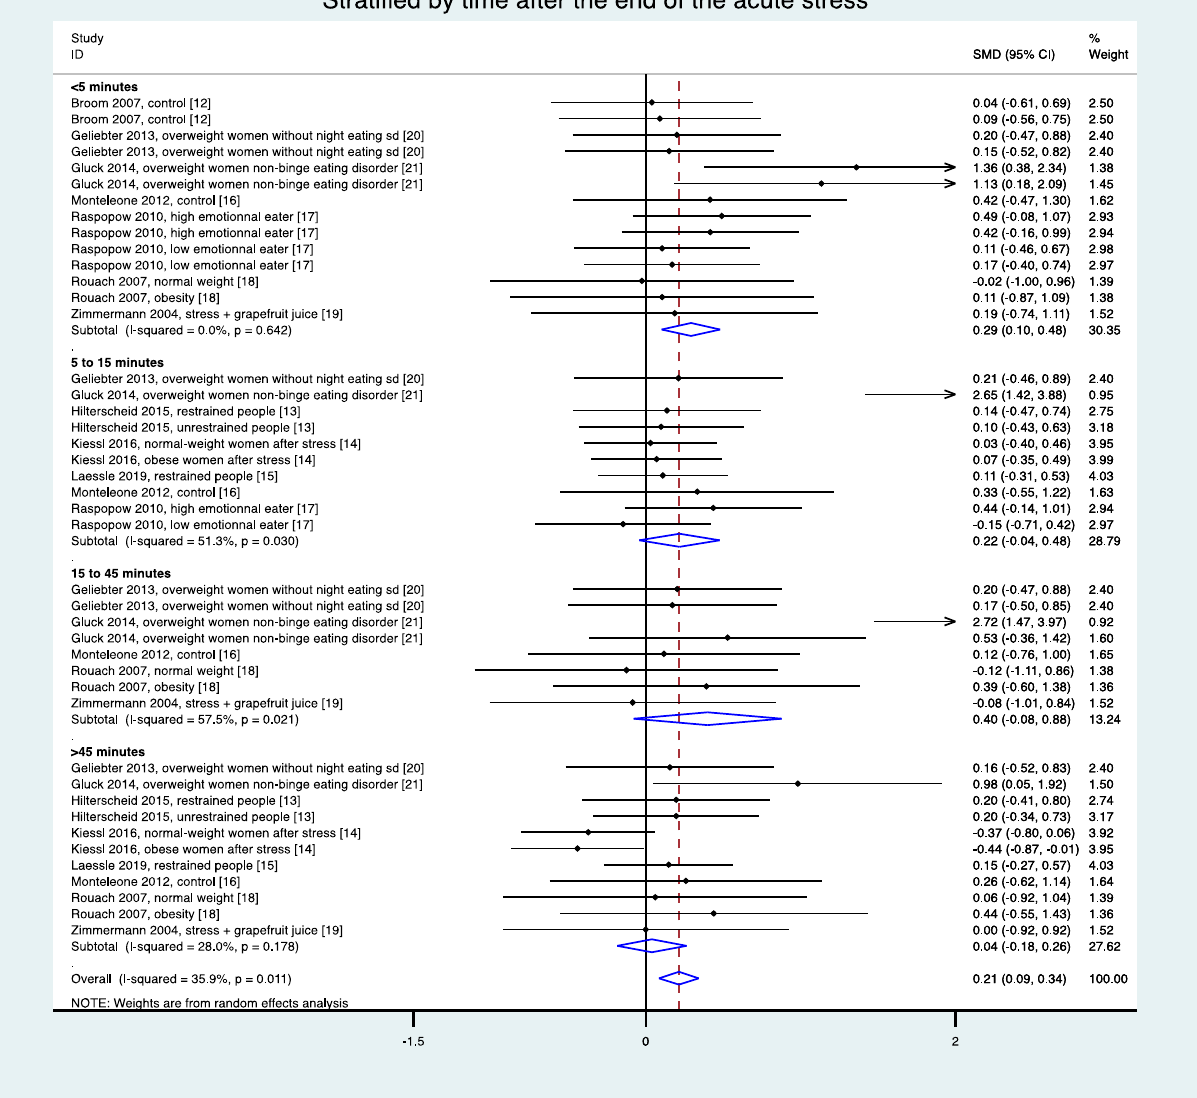
Figure 3. Meta-analysis of ghrelin levels following acute stress compared to baseline levels, stratified by time after the initiation of the acute stress intervention.